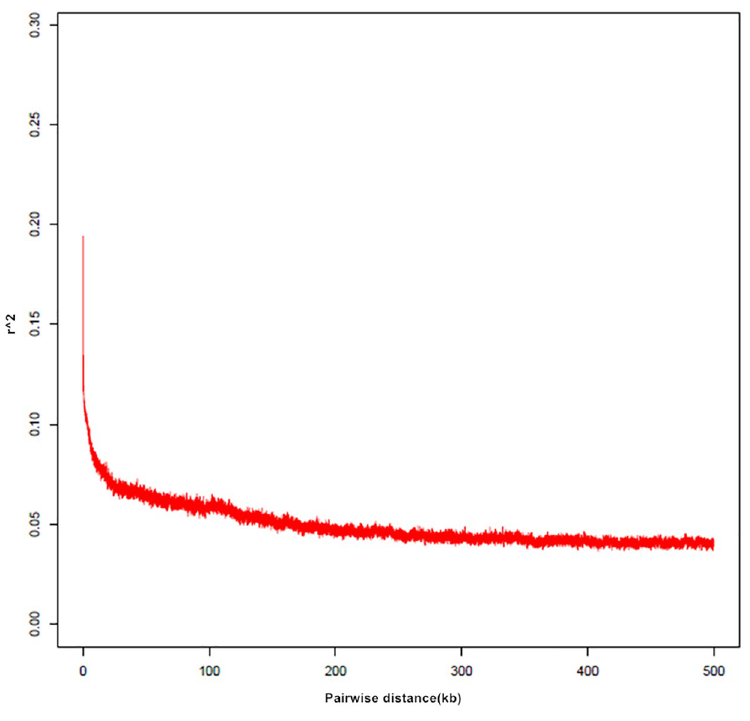
Fig 3. GWAS population LD decay map.